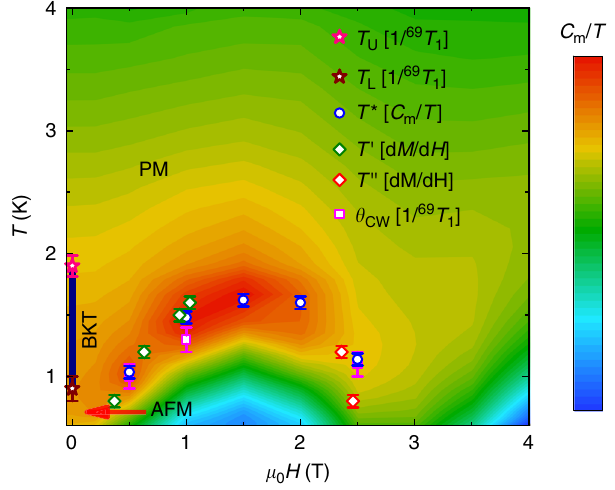
Fig. 1 Phase diagram of TmMgGaO 4 under out-of-plane magnetic fi elds. Under zero fi eld, there are paramagnetic (PM), BKT, and antiferromagnetic (AFM) phases. The T U ( T L ) is the upper (lower) BKT transition temperature, determined from the plateau structure in the NMR spin-lattice relaxation rate 1/ 69 T 1 (see Fig. 2 c for details). The BKT phase between T U and T L is illustrated by the solid vertical line, while the AFM regime is indicated by the arrow. The contour background depicts the magnetic speci fi c heat C m / T at various fi elds and temperatures, with data adapted from ref. 16 and plotted in logarithmic scale. T * corresponds to the maximum of C m / T at each fi eld, signifying the position of strong magnetic fl uctuations. T 0 ( T ″ ) denotes the temperature at a speci fi c fi eld where a peak is found in the differential susceptibility dM / dH , shown in Fig. 3b. The Curie – Weiss temperature θ CW is obtained from the 1/ 69 T 1 T (see Supplementary Fig. 1). Remarkably, T * , T 0 , T ″ , and θ CW all collapse to the same phase boundary between the BKT-like regime and AFM phase. A magnetically ordered phase is supposed to lie below the dome-like boundary. Errors represent 1 SD throughout the